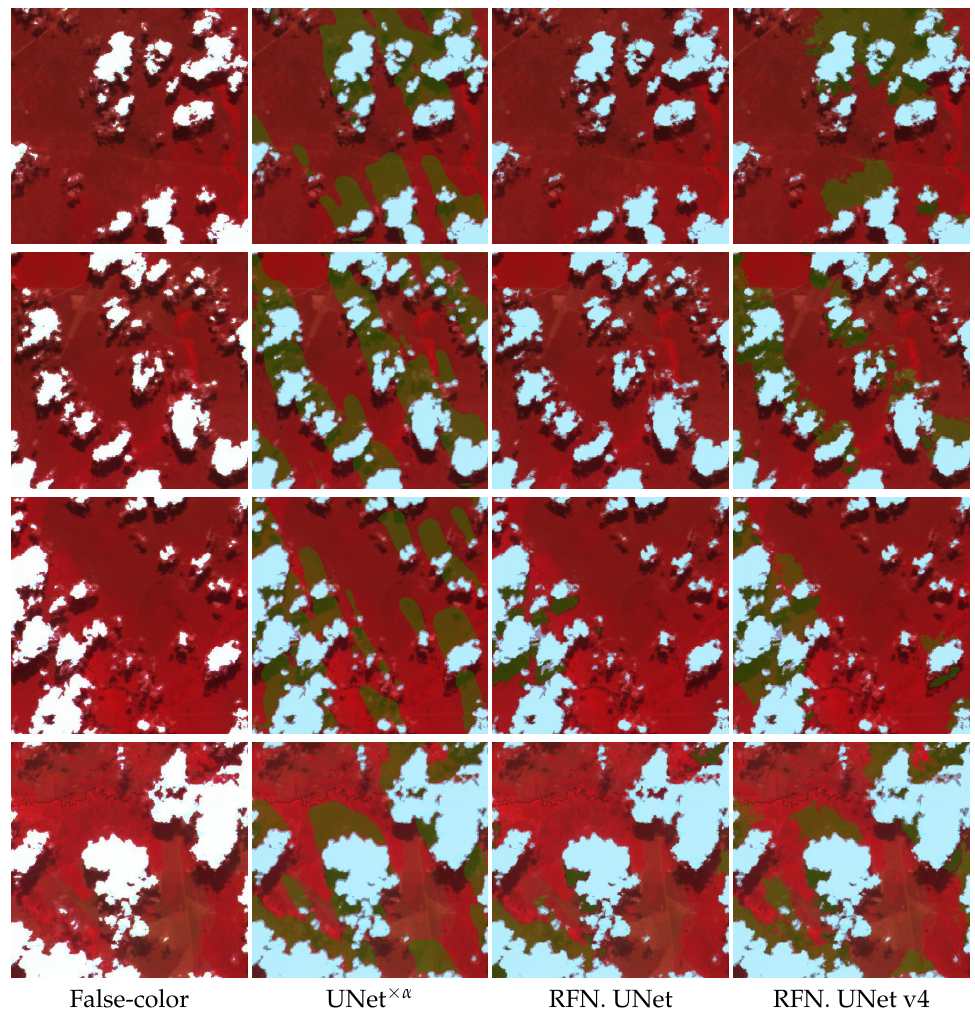
Figure 5. Illustrations of segmentation proposals from a local perspective